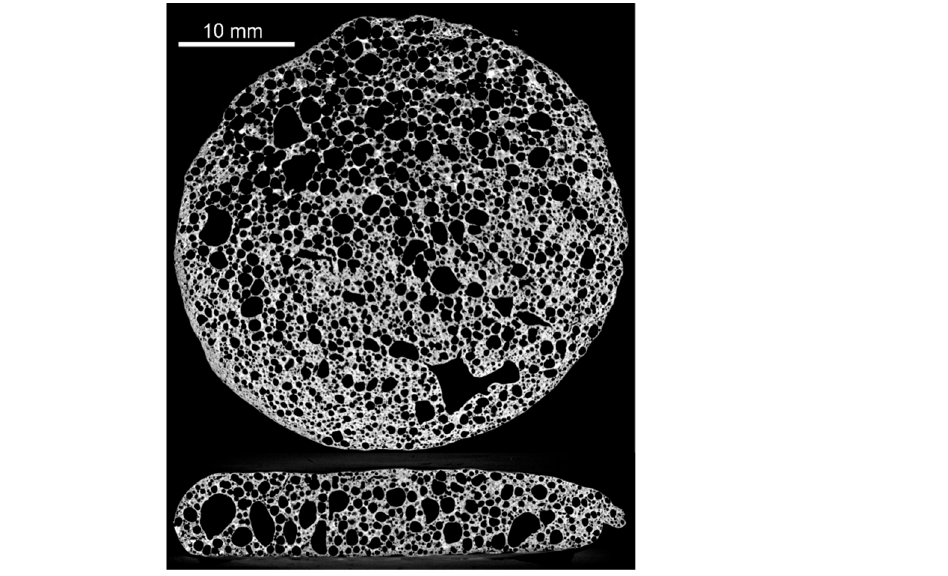
Figure 10. XRM sectional images of sample no. 12 (sample category II): foaming temperature, 625 °C; foaming time, 1 min; 0.5 wt.% TiH 2.